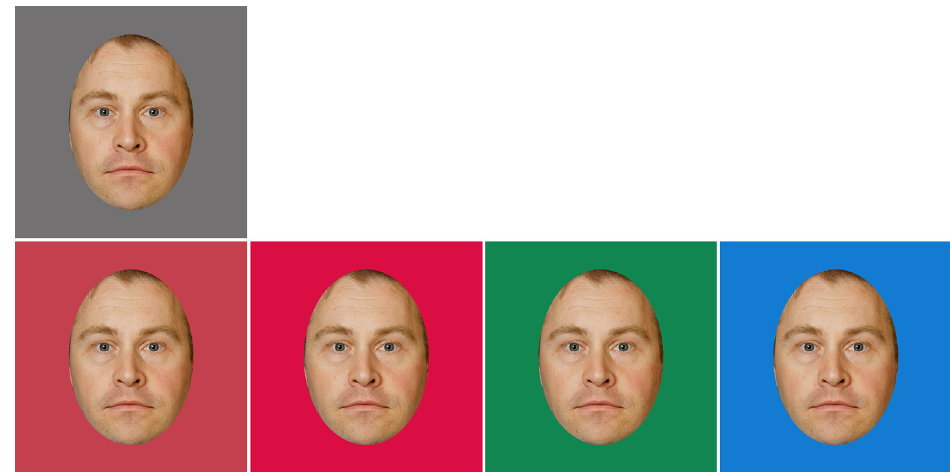
Fig 3. The background conditions. The neutral baseline condition on the top and the red, red+, green and blue conditions below.